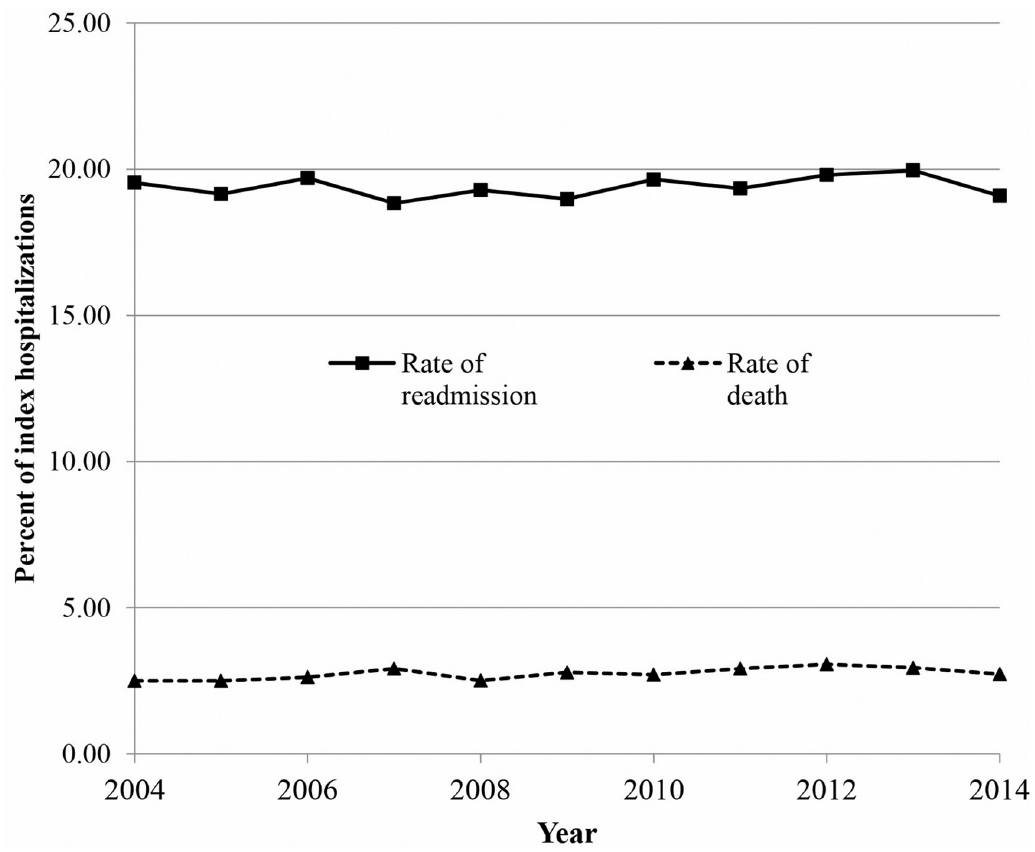
Fig 2. Rates of all-cause readmission and death within 30 days of a COPD hospital